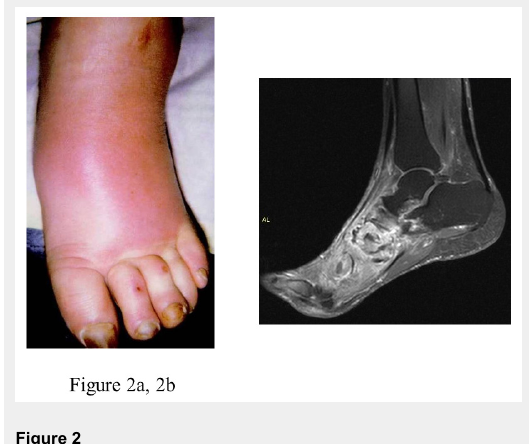
a: clinical aspect of an acute Charcot foot stage 1. b: MRI (T1w, fat suppressed, with contrast media) showing bone marrow oedema and impact fractures in the Lisfranc joints, a fluid collection with circular structure (equivalent to synovial fluid leakage and/or fracture hematoma) in the tarsal region, and adjacent soft tissue oedema (bright appearance).